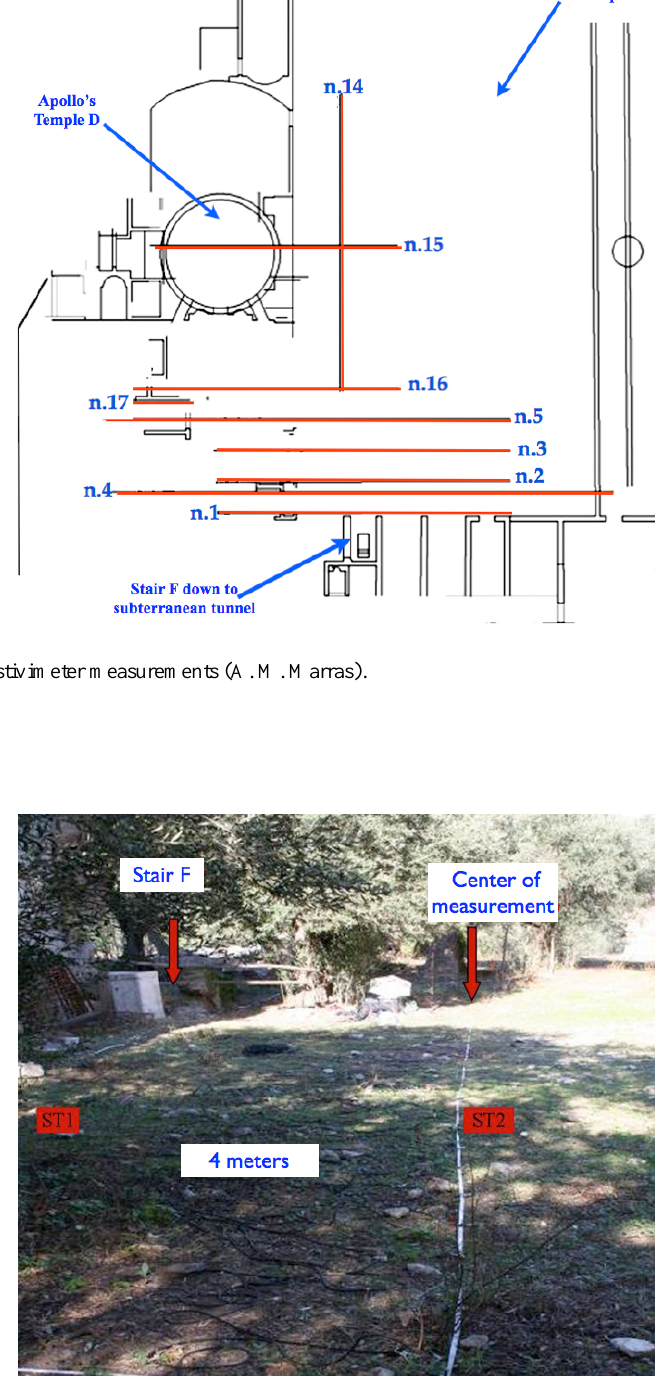
Adv. Geosci., 24, 3–13,